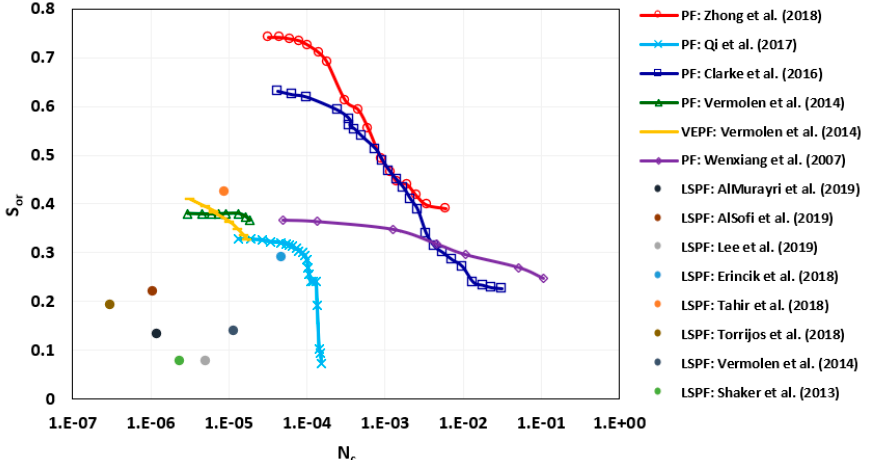
Figure 6. Capillary desaturation curves (CDCs) showing the higher microscopic efficiency of LSPF compared to conventional PF based on coreflood studies. VEPF: viscoelastic polymer flooding.